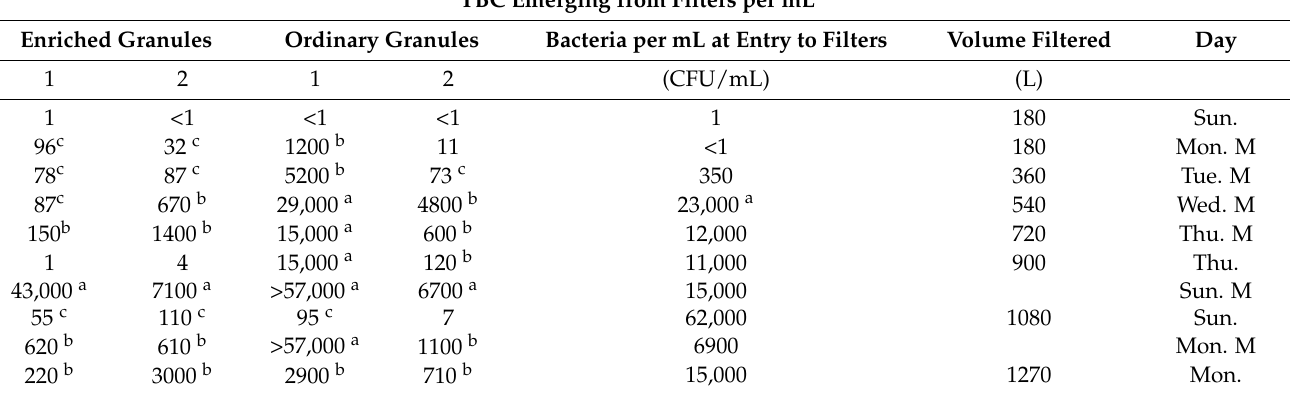
Table 2. Removal of bacteria from drinking water by filters containing an ordinary or enriched granular complex (15% increased amount of cation during preparation of